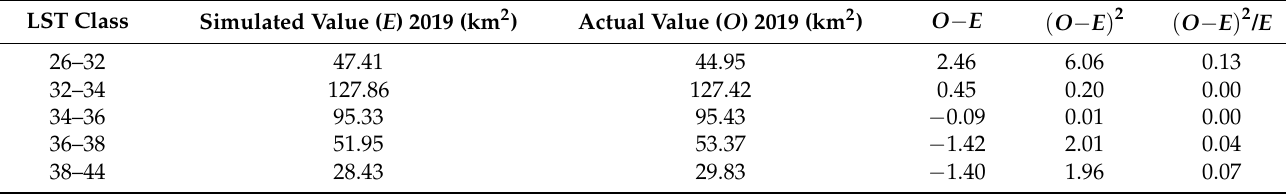
Table 7. Validation statistics of Markov model LST map prediction for